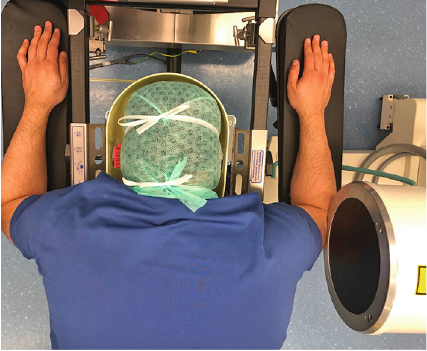
Figure 2: Radial nerve sustained a compression by the C-arm fl uoroscopy — global view.